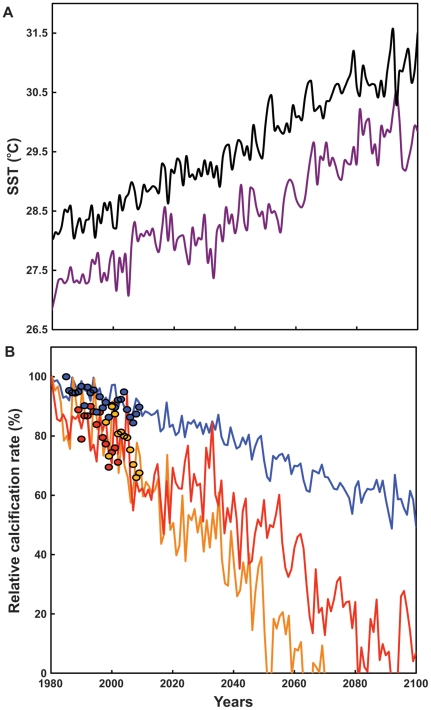
Modeled sea surface temperature and decreasing calcification rates for massive Porites spp. and Montastraea spp. from 1980 to 2100.(A) Modeled yearly mean sea surface temperature (SST) for the central Great Barrier Reef (purple line) and the Caribbean (black line) from 1980 to 2100. Modeled SST data are from Figures 10C and 8C in [32], respectively. (B) Modeled yearly mean relative calcification rate from 1980 to 2100 for massive Porites spp. (red line) in the Great Barrier Reef and P. astreoides (orange line), and Montastraea spp. (blue line) in the Mesoamerican Barrier Reef System. Yearly mean calcification rate data were generated with the regression lines of the relationship between calcification rate and SST (Figure 1) for massive Porites spp. growing in Rib Reef and P. astreoides, and Montastraea faveolata growing in Chinchorro Bank, using the modeled yearly mean SST presented in figure 2A. Red, orange and blue circles are the historical relative calcification rates of massive Porites spp. in Rib Reef and of P. astreoides, and M. faveolata in Chinchorro Bank, respectively.